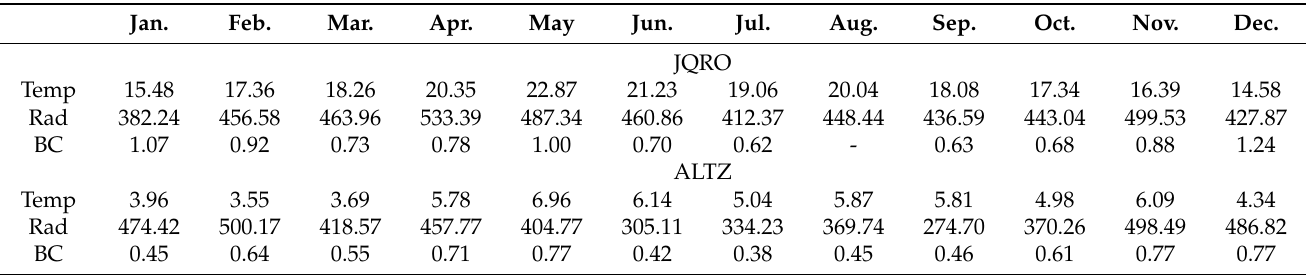
Table 2. Monthly temperature ( ◦ C), radiation (Wm − 2 ) and BC concentration ( µ g m − 3 ) data of JQRO and ALTZ in